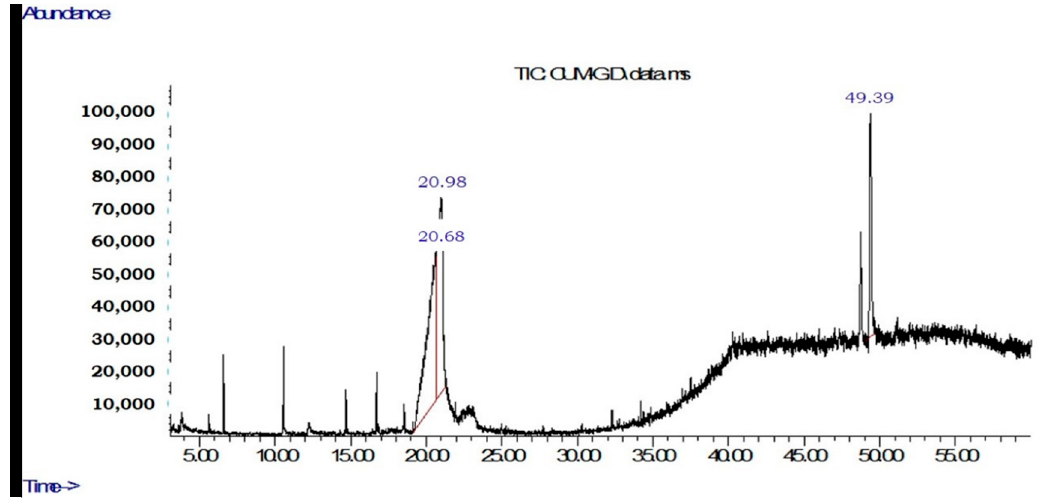
Figure A3. Dipteryx odorata branches extract chromatogram.